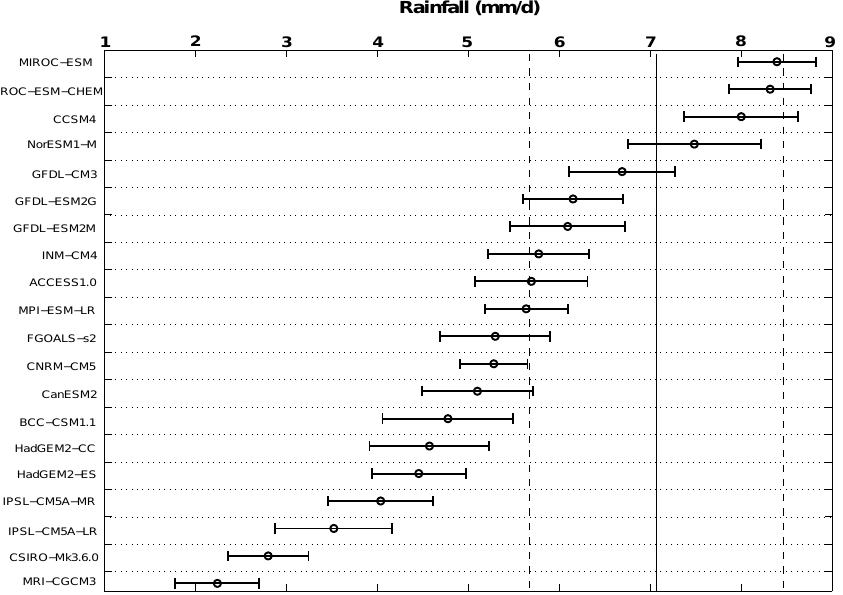
Fig. 1. JJAS mean rainfall over all India region from different models for the historic period. The black vertical line shows the all India mean monsoon rainfall from observations for the period 1871–2004, and the dashed lines show mean plus/minus twice the standard deviation of all India mean rain. Circles with error bars represent mean and mean plus/minus one standard deviation for the 20 comprehensive models from 1871 to